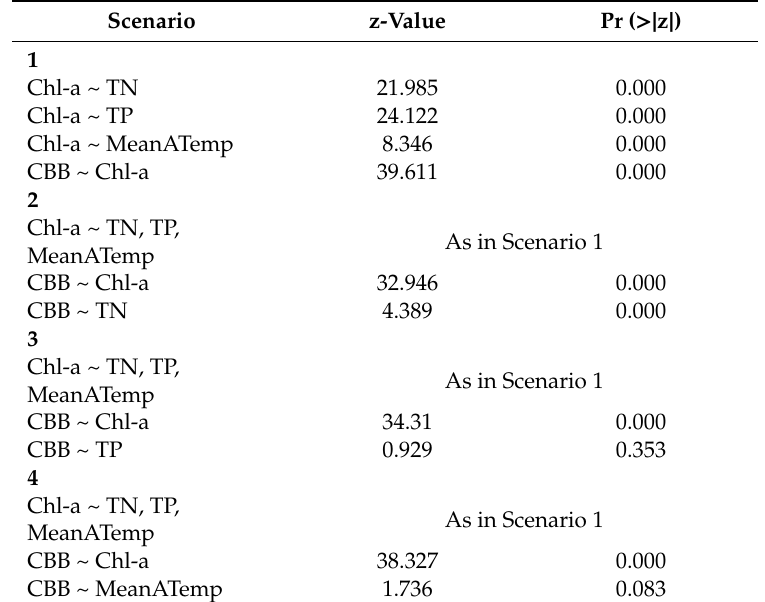
Table 5. Results of the path analysis concerning the four competing scenarios tested. For each direct relationship the z-value and Pr ( >| z | ) are